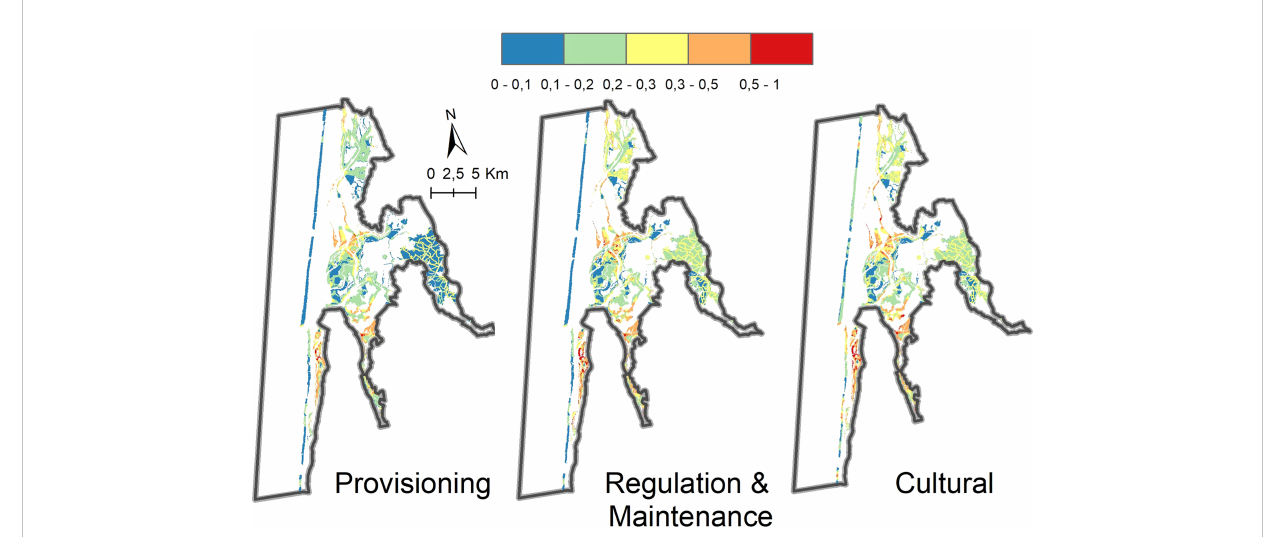
FIGURE 7 Ecosystem-service vulnerability in the Ria de Aveiro. Maps show the vulnerability scores obtained by multiplying cumulative risk by ecosystem services availability (normalized from 0 to 1). Each panel shows one of three ES